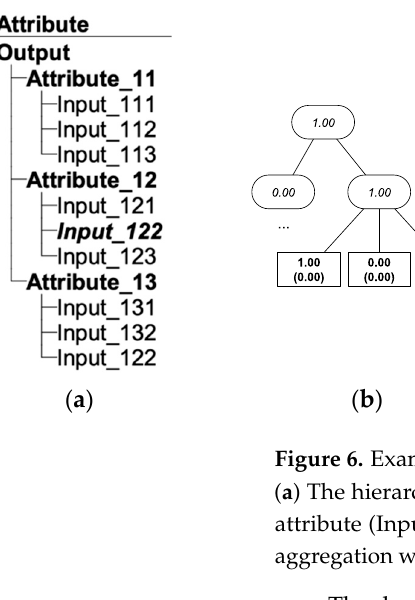
Figure 5. Structure of a DEX decision model for the assessment of primary productivity of agricultural fields [24].